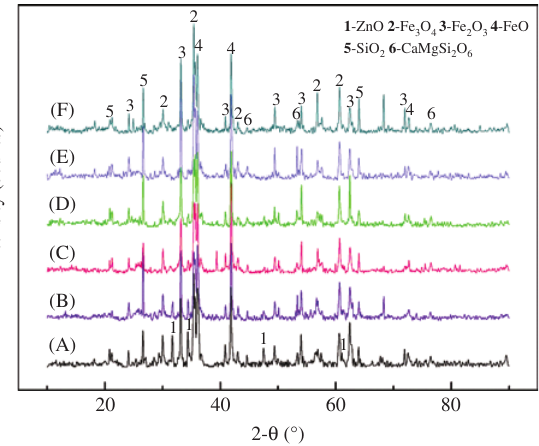
Figure 5: XRD patterns of raw material and leaching slags formed in different leaching agents as shown in Table 2. (A) Raw material, (B) solution no. 5, (C) solution no. 4, (D) solution no. 3, (E) solution no. 2, and (F) solution no.